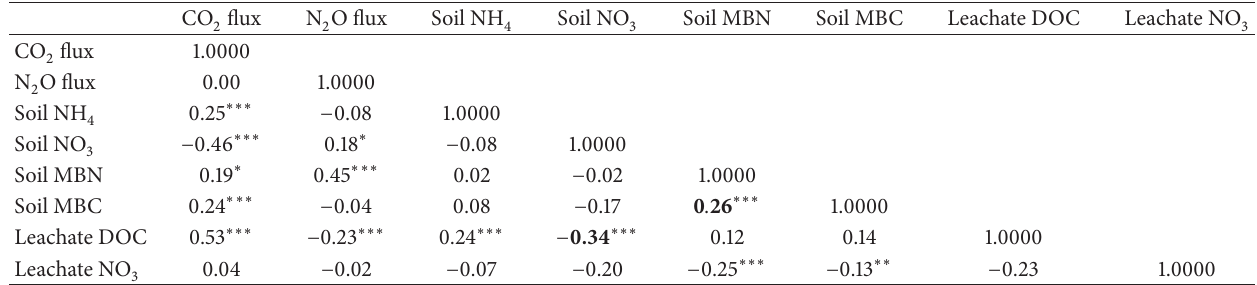
Table 6: Correlations between C and N losses via gaseous flux or in leachates and ancillary soil measurements, averaged from measurements ( 𝑛 = 144) taken at regular intervals during a 20 wks incubation study from microcosms filled with riparian soil without earthworms . Values are Spearman’s rank order coefficients ( 𝜌 ), with ∗ , ∗∗ , and ∗ ∗ ∗ indicating significant correlations at 𝑃 < 0.05 , 0.01, and 0.001, respectively, and NS = nonsignificant